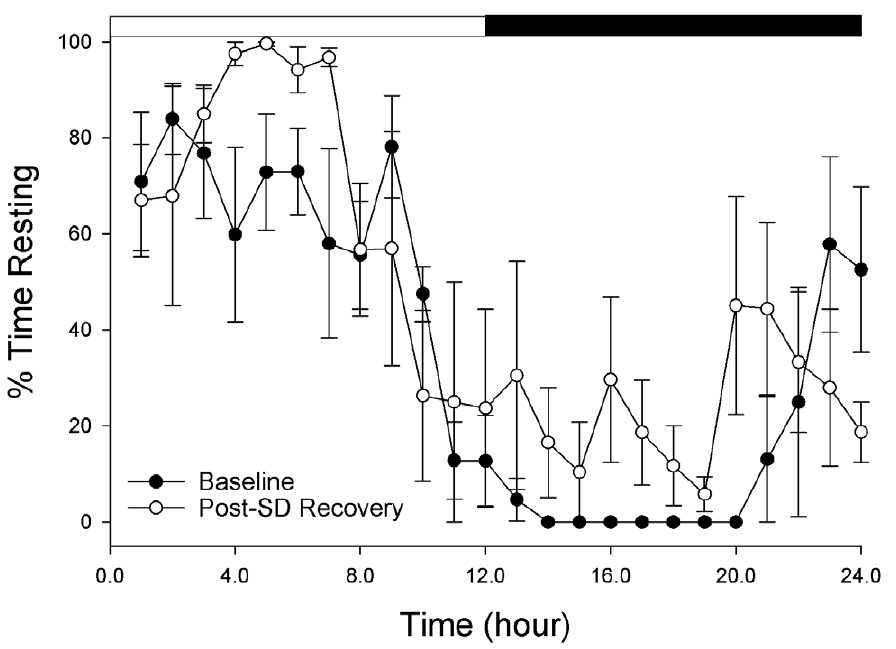
Figure 4. Quiescence (sleep) deprivation in the cuttlefish Sepiaofficinalis . Five juvenile cuttlefish were sleep deprived for 48 hours by continuous visual stimulation via a computer monitor positioned beneath their aquarium. During the following 24 hour recovery period, there was an overall compensatory increase in quiescence as revealed by a main effect of condition (baseline rest vs. after rest deprivation) in a 2 way ANOVA (Time and Condition as main factors): Condition: F=6.3, p , 0.013, Time: F=9.6 p , 0.001, interaction: F=1.3, p=0.18). Data are hourly mean ( 6 std. deviation) behavioral scores.